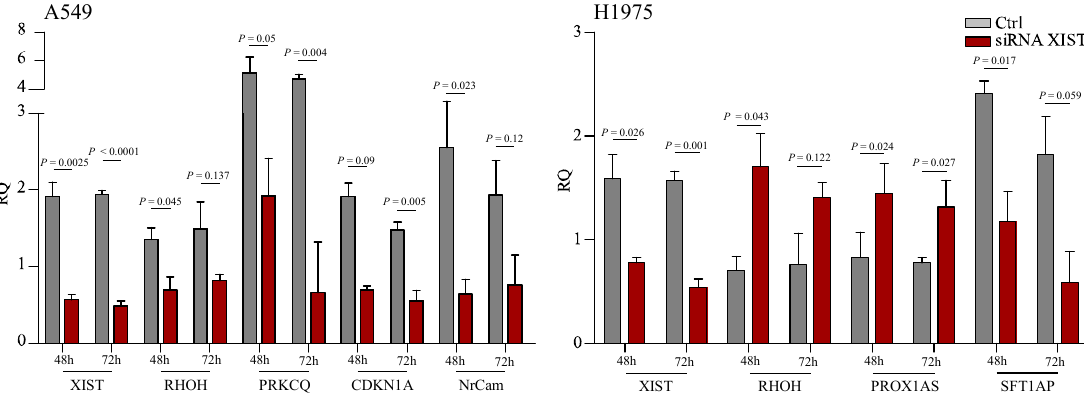
Figure 7. Relative expression of selected targets validating RNAseq data. For A549 cell line, XIST, RHOH, PRKCQ, CDKN1A and NrCam were validated using qRT-PCR. Significant downregulation corroborated the RNA-seq data. Similarly, XIST, RHOH, PROX1AS and SFT1AP were also assessed. Downregulation of XIST and SFT1AP was noted and upregulation of RHOH and PROX1AS following siRNA transfection. These data also corroborate the trends seen in RNA-seq for this cell line.